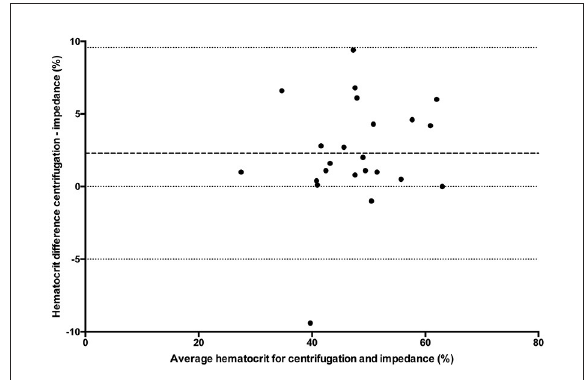
FIGURE3 Comparison of mean bias (bolder dotted line) and 95% limit of agreement (dotted lines) between the centrifuged hematocrit value and impedance